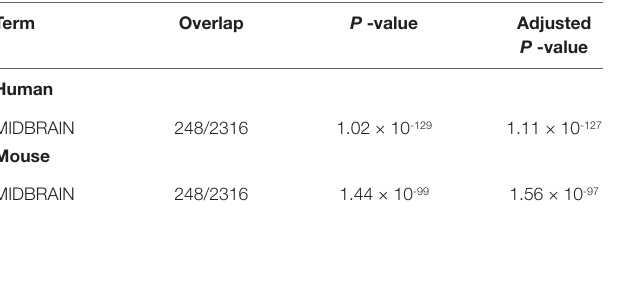
TABLE 6 | Enrichment of embryonic brain by “ARCHS4 Tissues” in Enrichr.